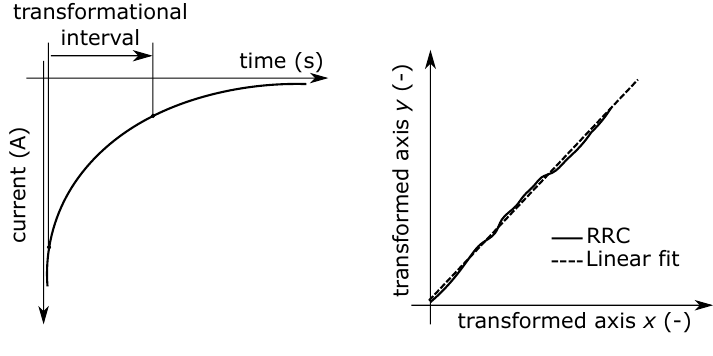
Figure 7. Transformation of resorption current to RRCs.